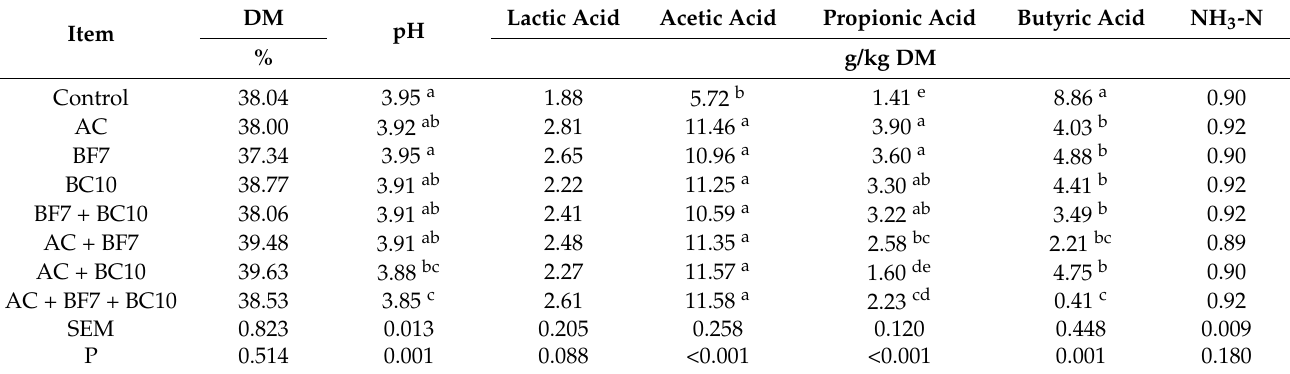
Table 3. Silage quality of cassava root silage prepared with additives measured after 30 days of